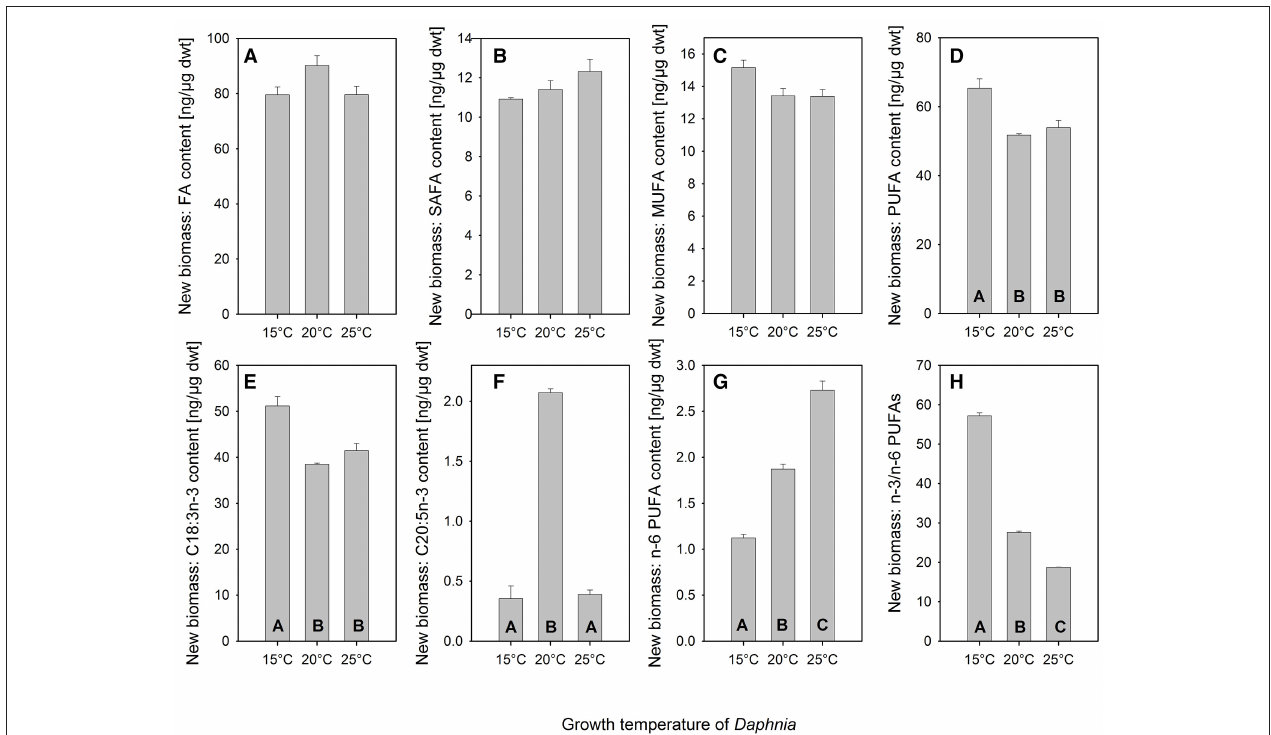
FIGURE 5 | Mean ( + SE, n = 3) fatty acid content of newly built biomass of D. magna grown at 15, 20, or 25 ◦ C on the green alga Chlamydomonas klinobasis , which was grown at the same temperature as Daphnia respectively. Depicted are the content of (A) total fatty acids (FA), (B) saturated fatty acids (SAFA), (C) monounsaturated fatty acids (MUFA), (D) polyunsaturated fatty acids (two and more double bonds, PUFA), (E) C18:3n-3, (F) C20:5n-3, (G) n-6 PUFAs, and (H) the ratio of n-3 PUFAs to n-6 PUFAs. Different letters indicate significant differences between treatments (Tukey’s HSD after one-way ANOVA). Note different